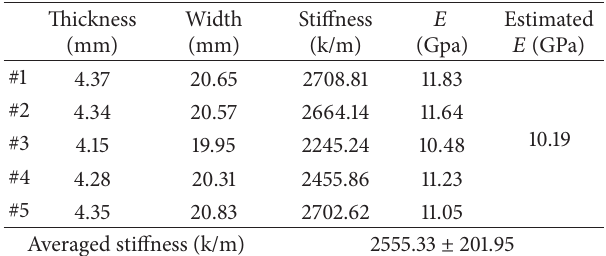
Table 7: Specifications of the half-circular composite leg made